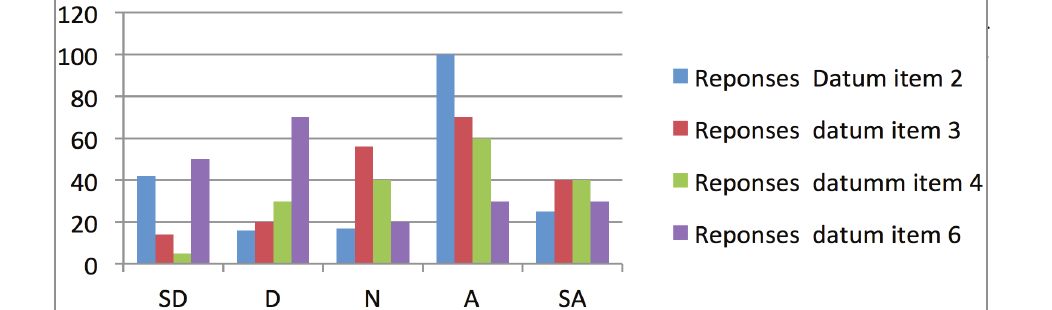
Figure 9: Responses for data items theme 2 Datum item